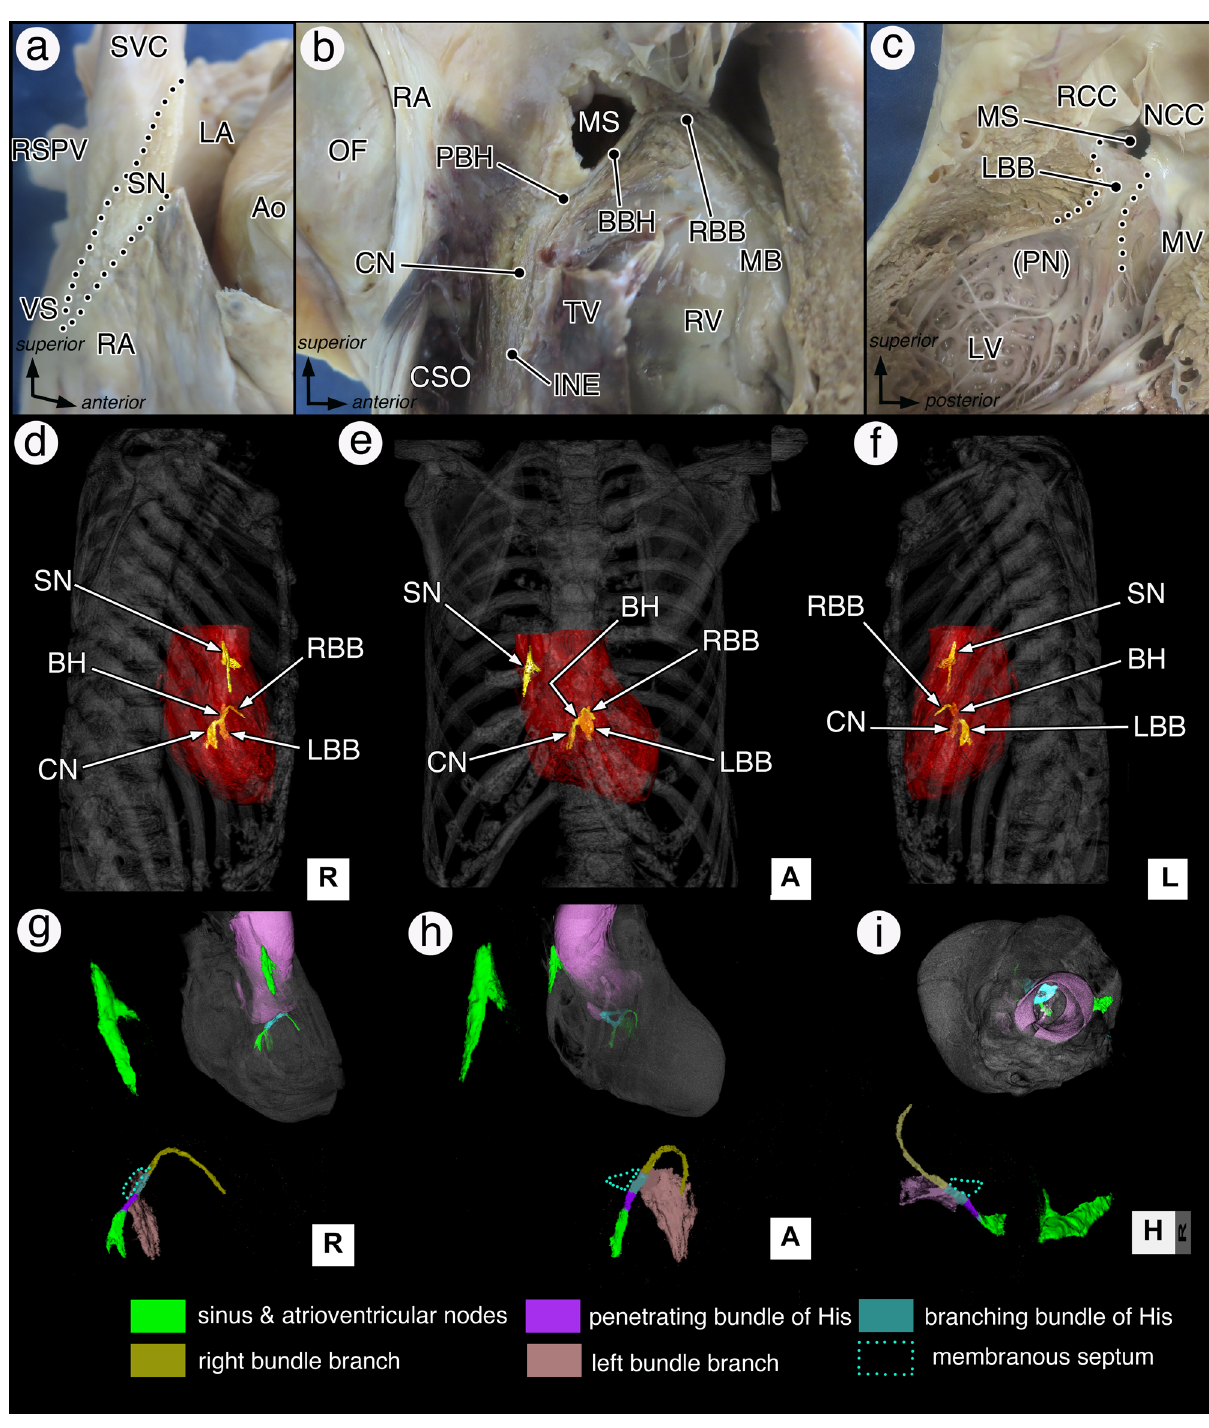
Figure 1. Physical and virtual dissection of the human CCS from the sinus node to the bundle branches in the standard oblique heart. The physical dissection of the sinus node situated at the terminal groove in the right anterior oblique view ( a ), the atrioventricular conduction axis from the compact node to the right bundle branch in the right chamber view ( b ), and the left bundle branch in the left chamber view ( c ). The virtual dissection of the three-dimensional (3D) architecture of the CCS and its segmented components within the body in the right lateral ( d,g ), frontal ( e,h ), left lateral ( f ), and superior ( i ) views, respectively. Ao aorta, BBH branching bundle of His, CN compact node, CSO coronary sinus orifice, INE inferior nodal extension, LA left atrium, LBB left bundle branch, LV left ventricular, MB moderator band, MS membranous septum, MV mitral valve, NCC non-coronary cusp, OF oval fossa, PBH penetrating bundle of His, PN Purkinje network, RA right atrium, RBB right bundle branch, RCC right coronary cusp, RSPV right superior pulmonary vein, RV right ventricle, SN sinus node, SVC superior vena cava, TV tricuspid valve, VS venous